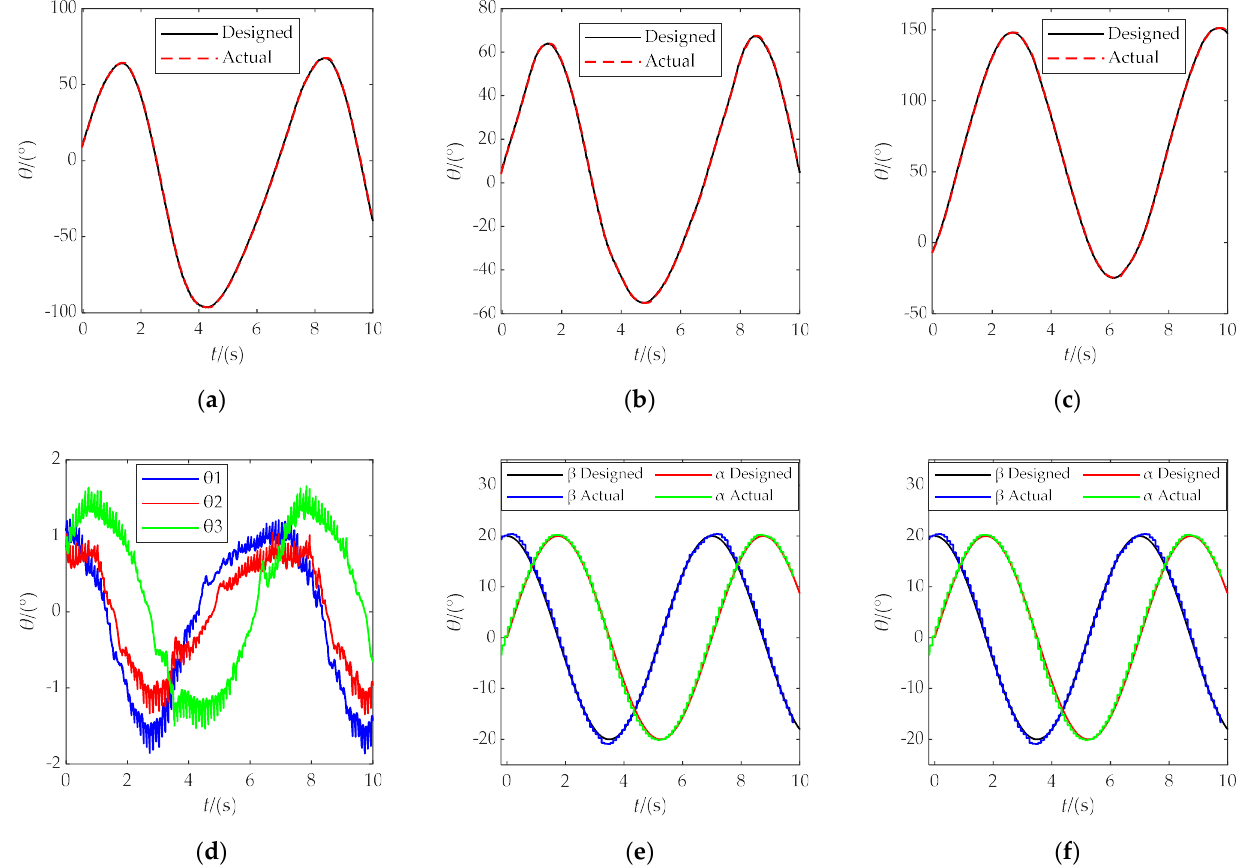
Figure 14. ( a ) The motion law of motor 1; ( b ) the motion law of motor 2; ( c ) the motion law of motor 3; ( d ) the following error of motor; ( e ) the rotation law of the rotating center; ( f ) the following error of the rotating center.